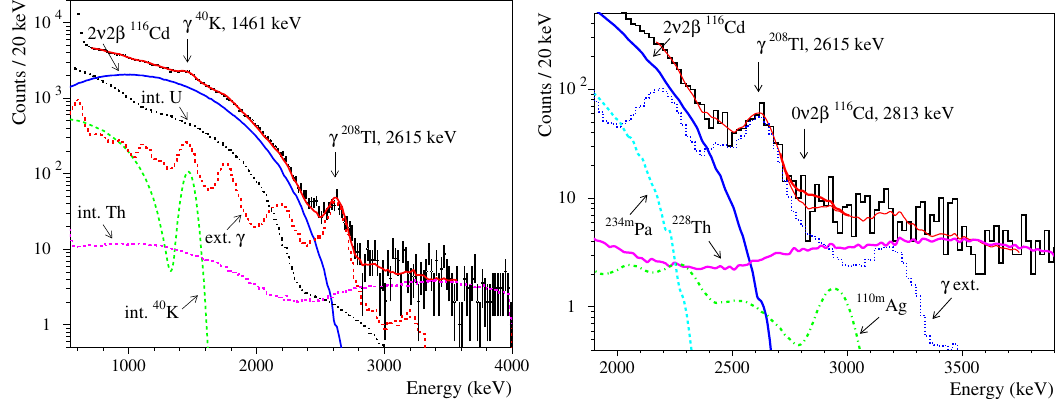
Figure 2. Energy spectrum of γ ( β ) events collected by the 116 CdWO 4 detectors in the region of interest for 2 ν 2 β decay (on the left, T = 26831 h) and 0 ν 2 β decay (on the right, T = 35324 h) of 116 Cd. Also shown are the main components of the background model: the 2 ν 2 β decay of 116 Cd, the internal contamination of the 116 CdWO 4 crystals by U/Th, K (“int. U“, “int. Th“, “ 40 K“) and contributions from external γ s (“ext. γ ” or “ext. Th.“). The peak of the 0 ν 2 β decay of 116 Cd excluded at 90% C.L. is also